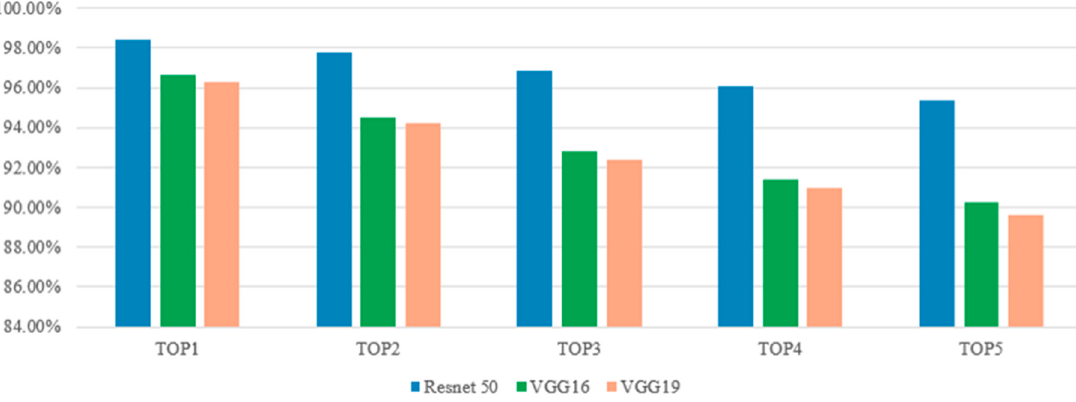
Figure 7. Performance of pre-trained models in hot pepper pest with top-1~top-5 results.